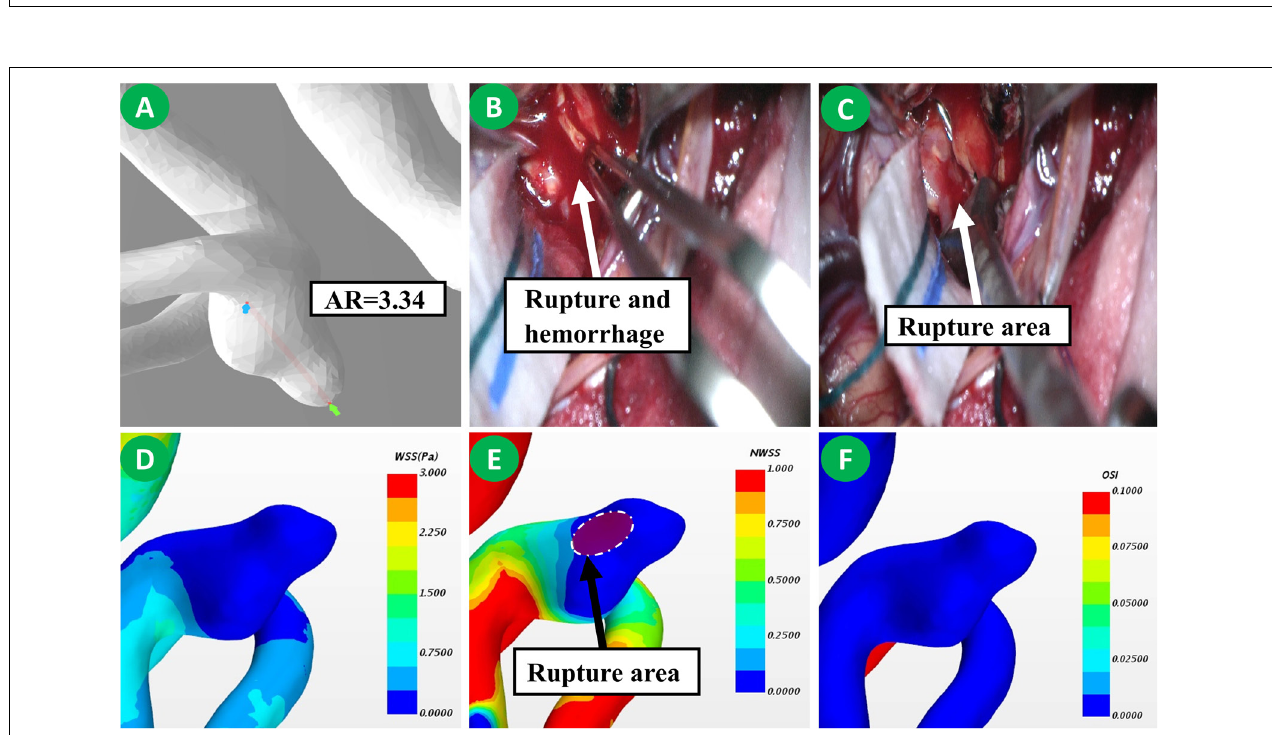
FIGURE 3 | This is a patient with IOR aneurysm. Its AR was 3.34 (A) . Rupture of the aneurysm occurs during dissection (B) . No significant thinning of aneurysms was observed during the operation, yet the bleeding area could be found (C) . Based on the hemodynamic analysis, the dome of the aneurysm has a low WSS but a lower NWSS. The rupture area was in the low WSS region (D,E) . No significant increase of OSI was observed (F)